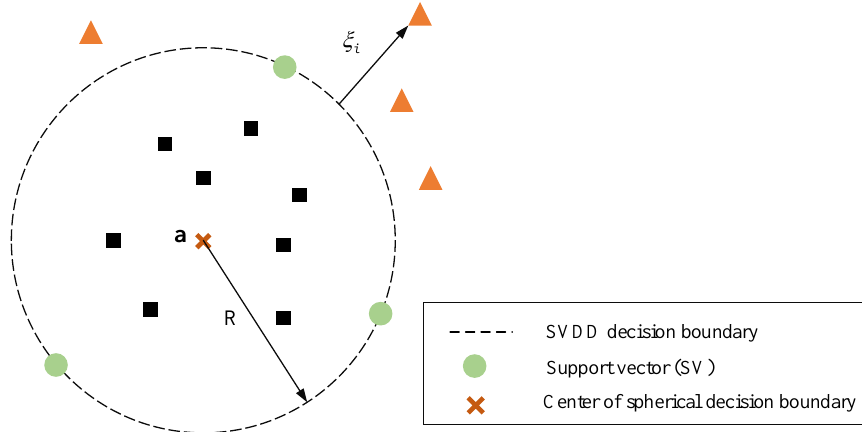
Figure 5. Schematic diagram of SVDD for fault detection in two dimensions.